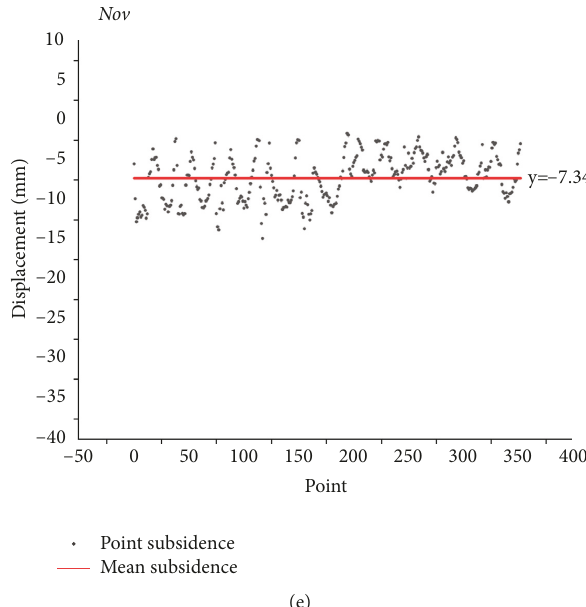
Figure 12: Analysis of subsidence in Zhanhua district combined with precipitation. (a) Monthly average precipitation curve in Zhanhua district, red square is precipitation in August. The deformation of 353 points in (b) January, (c) May, (d) August, and (e) November. The red line is the average deformation of 353 points in each